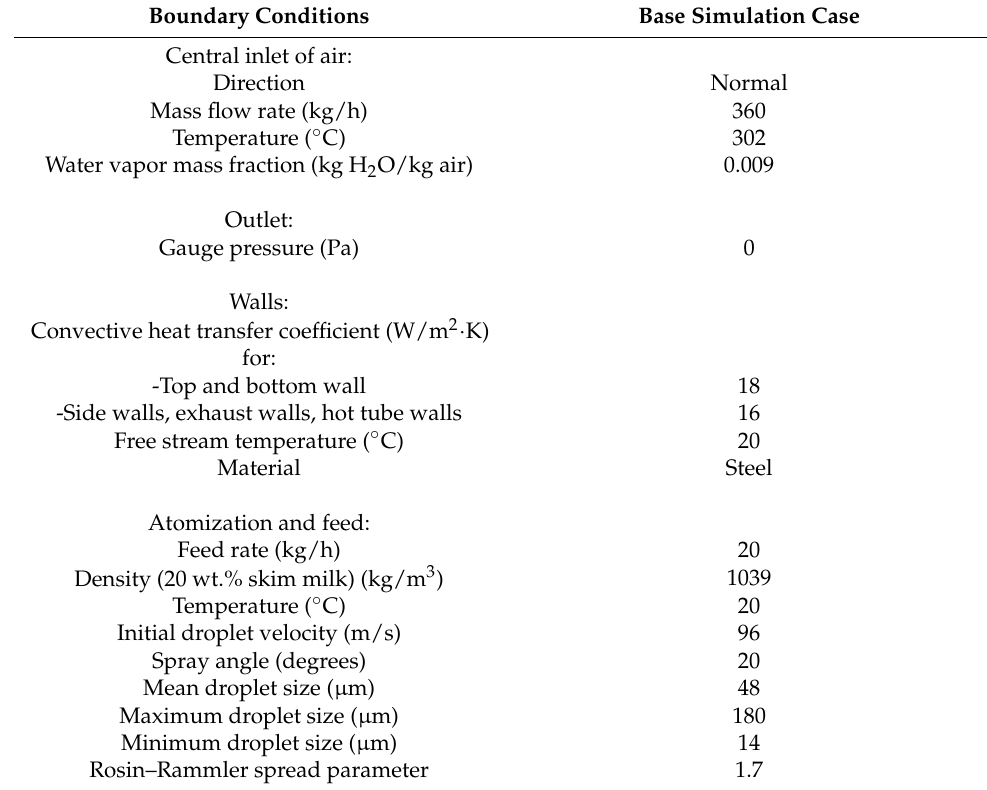
Table 1. Boundary conditions for the simulation case and experimental